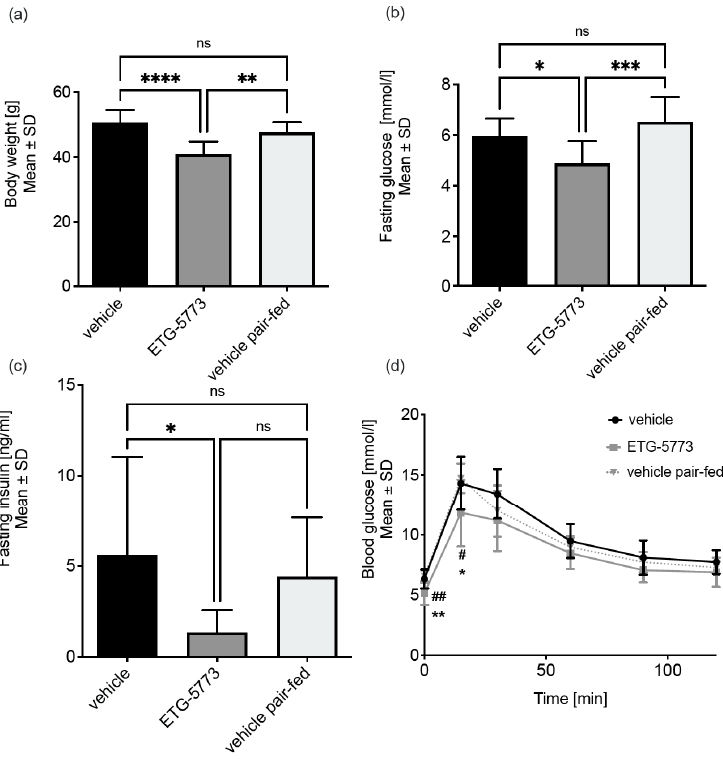
Figure 2. Treatment with ETG-5773 changes metabolic parameters in obese mice. ( a ) Body weight of DIO mice; ( b ) fasting blood glucose levels; ( c ) fasting serum insulin levels; * p < 0.05, ** p < 0.01, *** p < 0.001, **** p < 0.0001; ( d ) glucose tolerance test, # ETG-5773 vs. vehicle, * ETG-5773 vs. vehicle pair-fed, * or # p < 0.05, ** or ## p < 0.01, ns: non-significant, ANOVA, mean SD. Animals were treated orally twice a day with 15 mg/kg ETG-5773 or with the corresponding vehicle or vehicle in the pair-fed group, n = 12 vehicle and ETG-5773, n = 8 pair-fed.